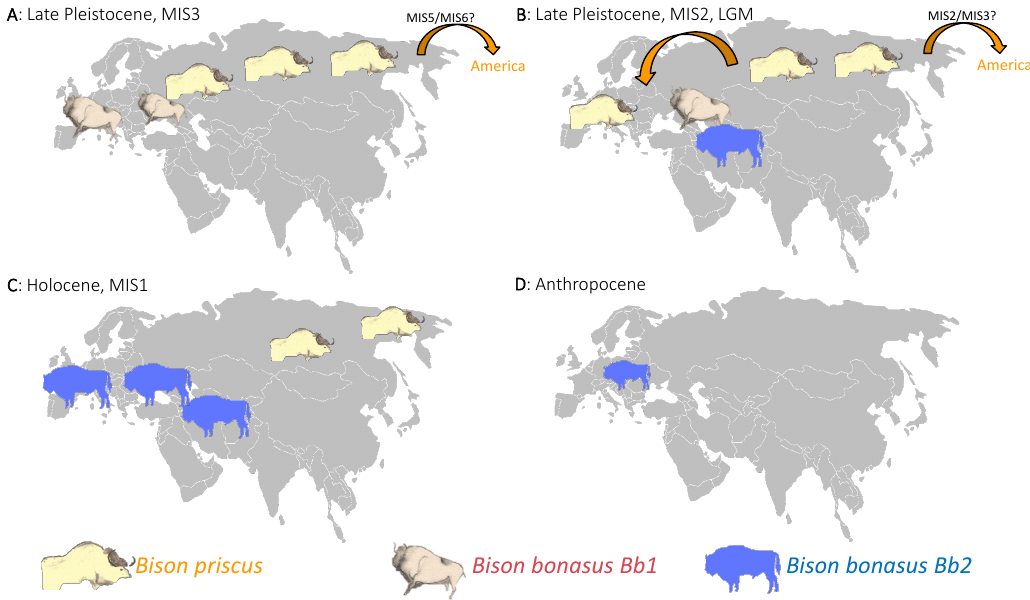
Figure 2. Schematic representation summarizing the population dynamics of bison on the Eurasiatic continent based on the various bison mitotypes from the Late Pleistocene to the present. The orange arrows indicate the migrations, and, for the migrations on the American continent, their putative date estimates are indicated alongside the arrows. ( A – D ) depict the situations at different time periods as indicated (Drawings of the Chauvet cave bison representations by E.M.